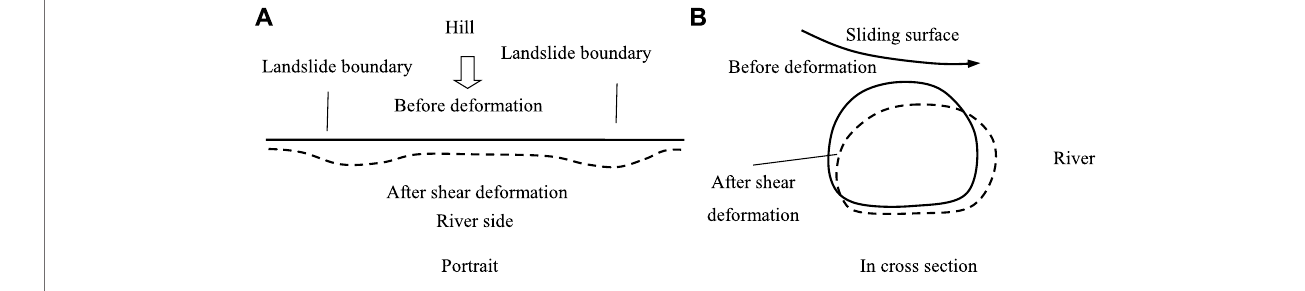
FIGURE 12 | Deformation diagram of the “ transverse pull ” mode.